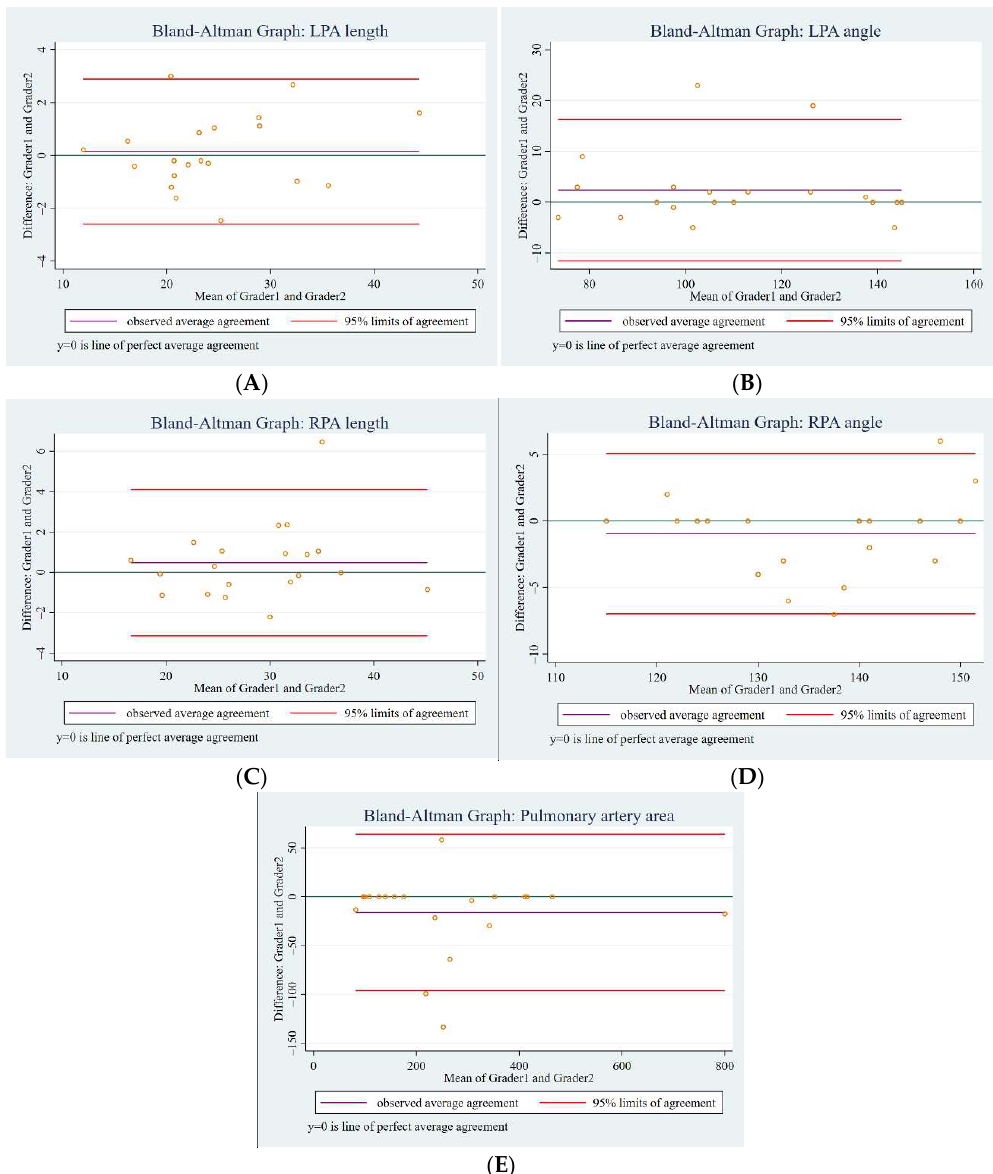
Figure 7. Bland–Altman plots of the inter-observer agreement in the measurements for LPA length ( A ), LPA angle ( B ), RPA length ( C ), RPA angle ( D ), and pulmonary area ( E ). The central violet line indicates the mean difference between the two graders. The upper and lower lines represent upper and lower margins of the 95% limits of agreement, respectively.